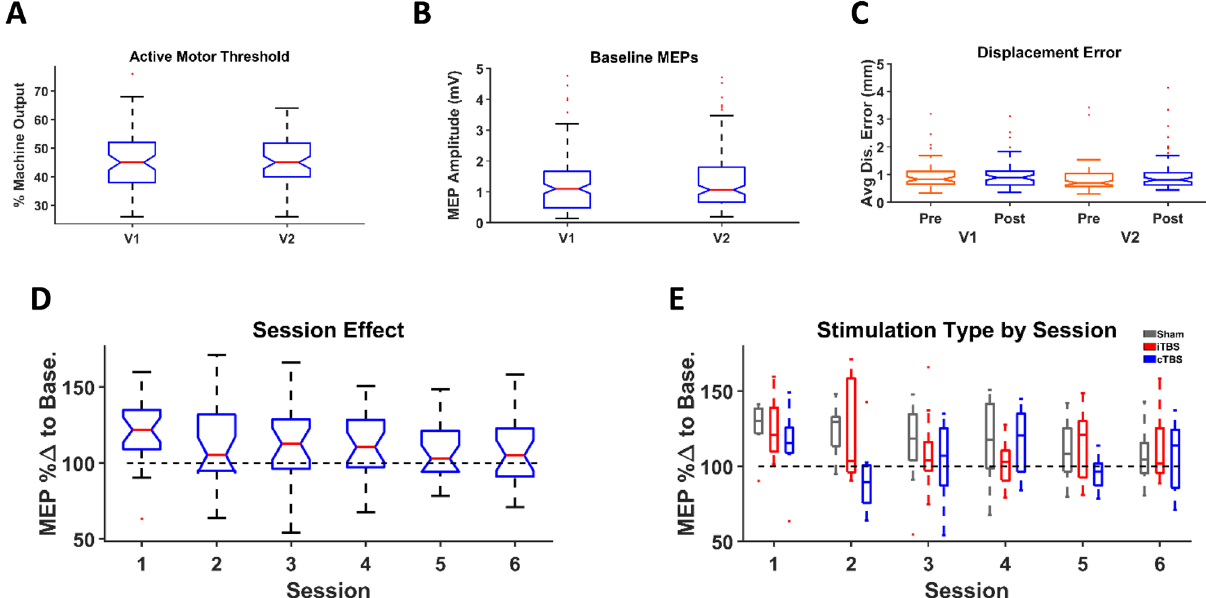
Figure 3. Control analyses. ( A ) Grand average of active motor threshold as a percentage of maximum machine output by V1 and V2 visits. ( B ) Grand average baseline MEP amplitudes (mV) by V1 and V2 visits. ( C ) Grand average of coil displacement error (mm) by V1 and V2 visits and separated into pre- and post-plasticity data. ( D ) Boxplot of post-TBS grand-averaged MEP percentage change from baseline by absolute visit number for all participants. ( E ) Box plot of post-TBS grand-averaged MEP percentage change from baseline by absolute visit number grouped by TBS protocols. Abbreviations: Avg Dis. Error - average displacement error. MEP %Δ to Base—motor evoked potential percentage change to